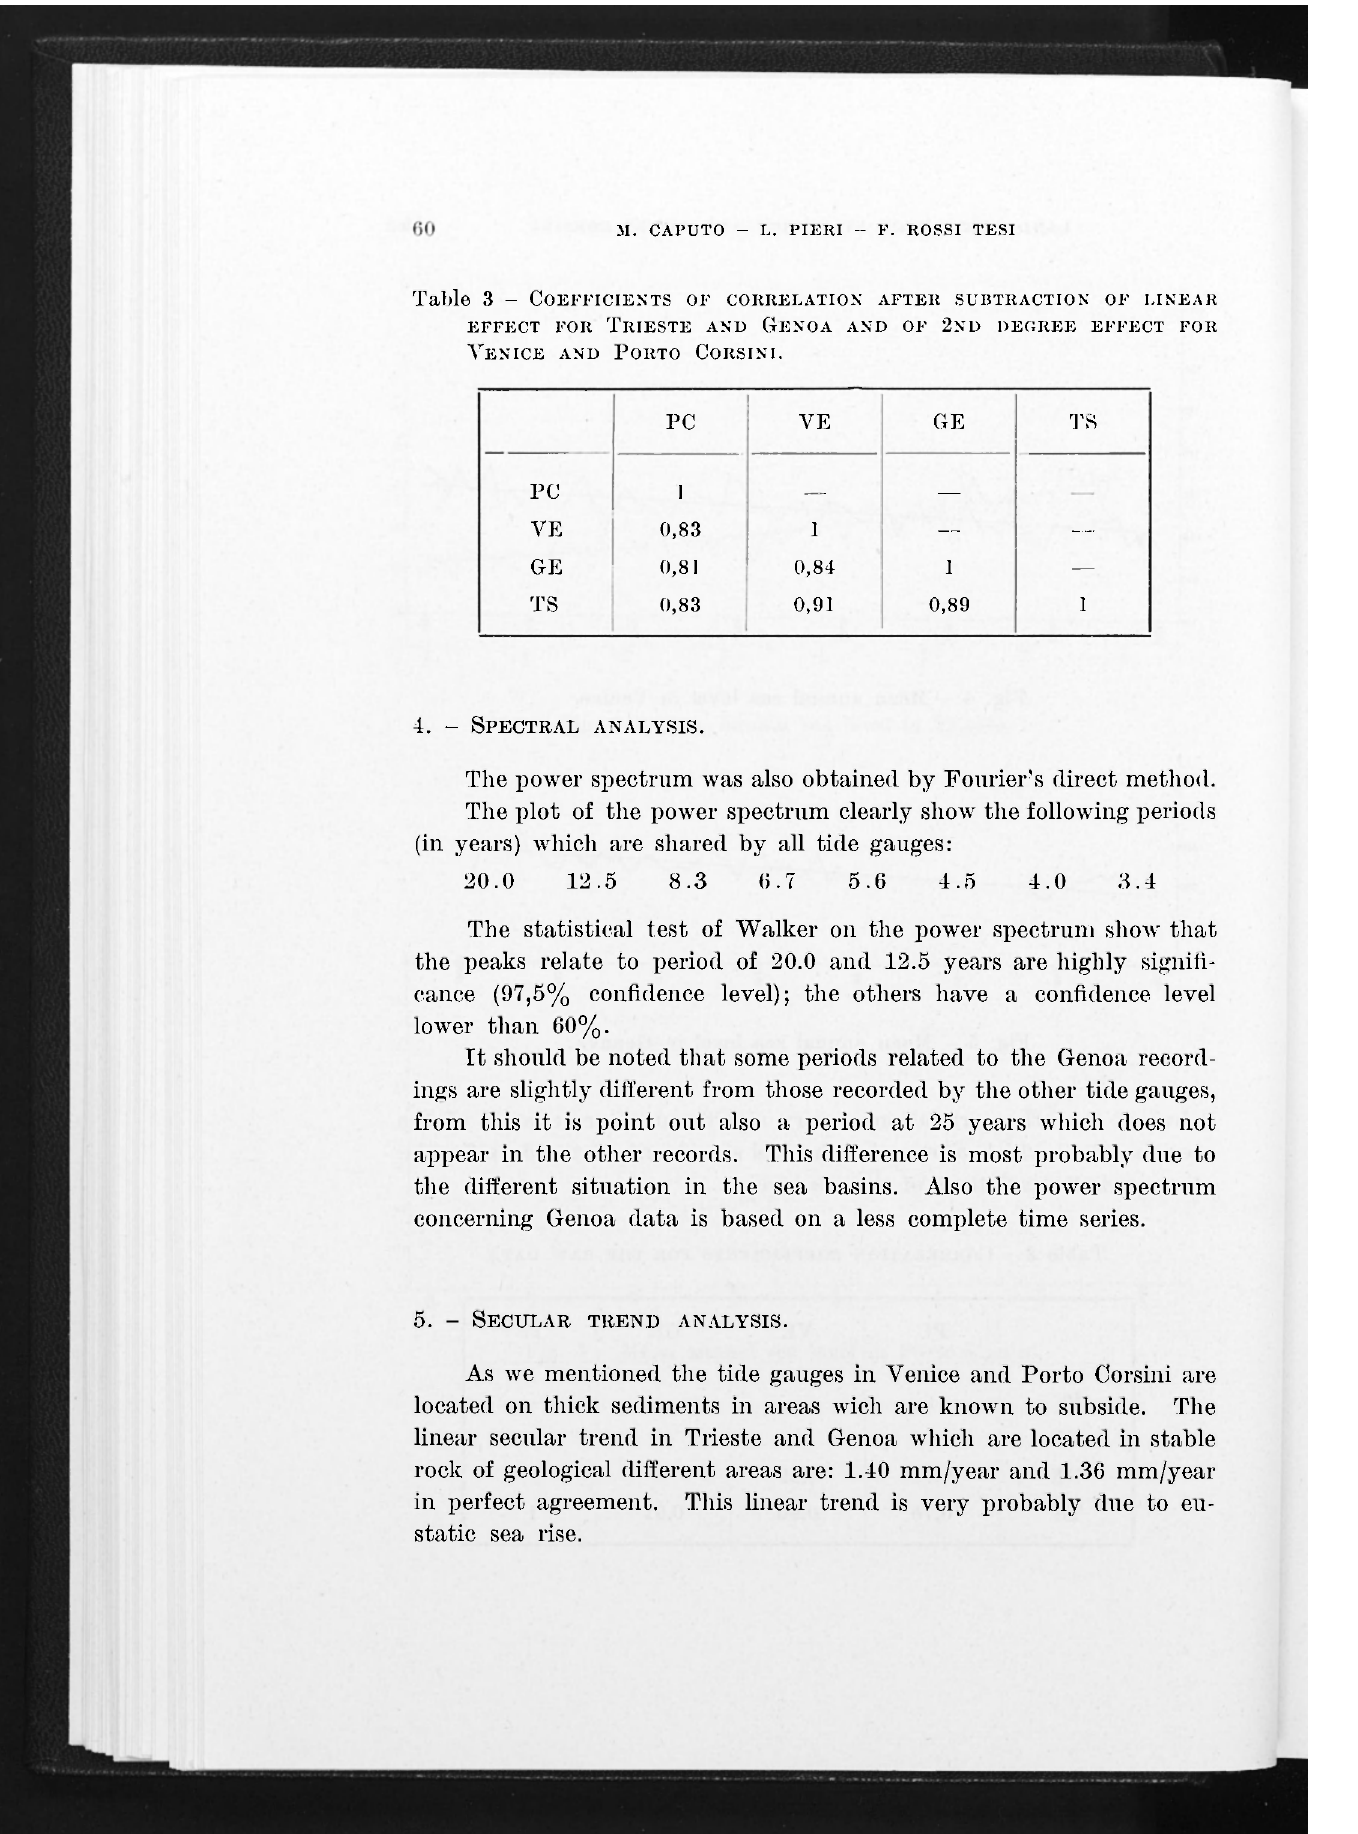
Table 3 - COEFFICIENTS OF CORRELATION AFTER SUBTRACTION OF LINEAR EFFECT FOR TRIESTE AND GENOA AND OF 2ND DEGREE EFFECT FOR VENICE AND PORTO